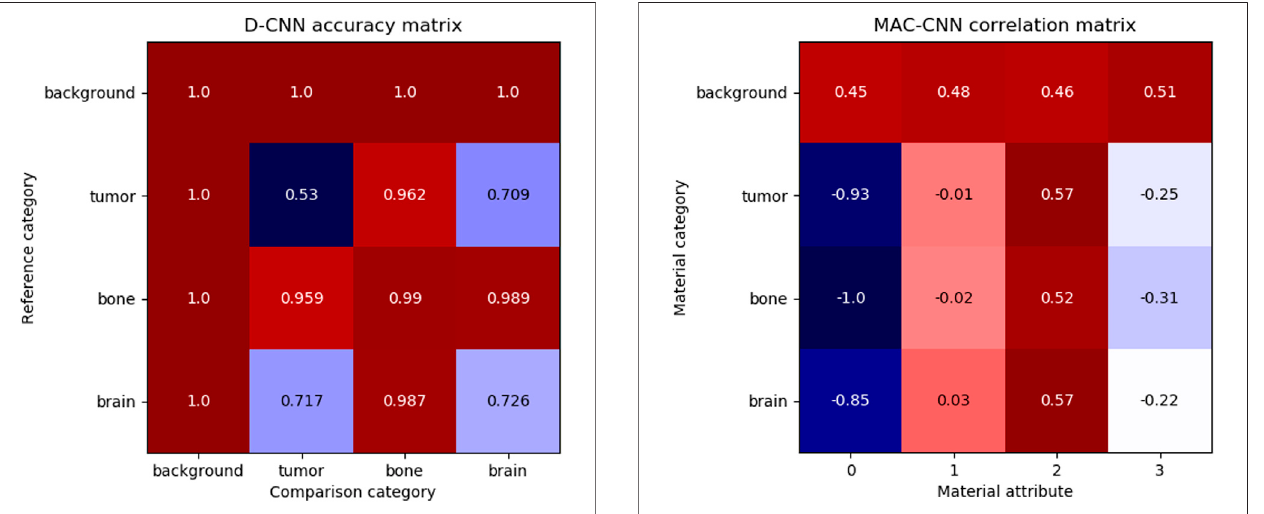
FIGURE 6 | The accuracy of the D-CNN making correct similarity decisions between reference and comparison patches of every pair of categories. The null category, background, was easily determined to be similar or dissimilar to other patches due to its homogeneity and difference from other classes of patches. Meanwhile, the D-CNN was less accurate at classifying more similar pairs of categories, such as brain and tumor. The less accurate comparisons result in a smaller perceptual distance in the D matrix.